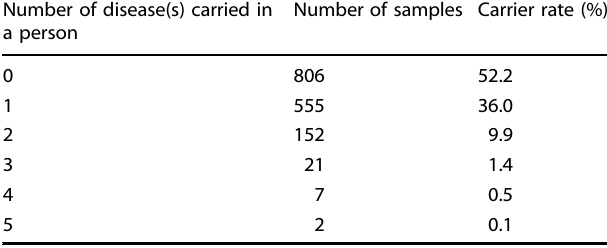
Table 3. Estimated burden of carriers in the Southern Chinese